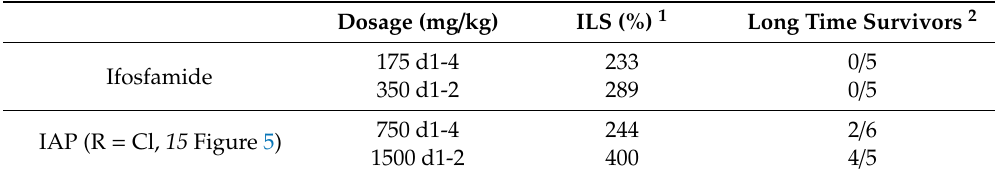
Table 4. Antitumor activity of equitoxic dosages of Ifosfamide and IAP in P388 tumor-bearing mice. Therapy was started on day 1 after 10 6 P388 tumor cells were subcutaneously transplantated in female CD2F1 mice. Ifosfamide was administered intraperitoneally, IAP was administered subcutaneously. 1 increase in life span (ILS), 2 surviving time > 100